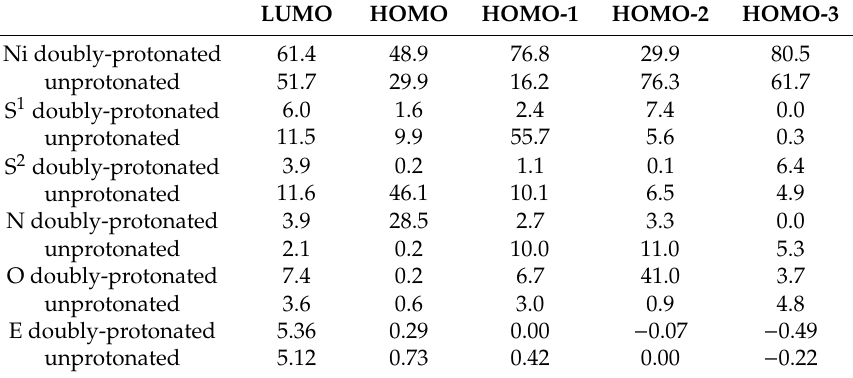
Figure 9. ( A ) Isosurface plots (0.03 a.u.) of the LUMO through HOMO-3 of the doubly-protonated (left) and unprotonated (right) computational models of the pH 7.4 form of the nickel-site of {Ni 2 (SOD mds )}. The energies were normalized to the non-bonding Ni(3d z2 ) orbital, highlighted in red. ( B ) Isosurface plots (0.03 a.u.) of the LUMO+1 through HOMO-5 of the disulfide bridged dinuclear {Ni 2 (SOD mds )} computational model. Table 1. Ni(3d), S(3p), N(2p), and water O(2p) Löwdin MO population analysis (%AO to MO) and energies (eV) relative to the Ni(3d z2 ) orbital for the LUMO through HOMO-3 of the computational models for doubly-protonated and unprotonated monomeric {Ni 2 (SOD mds )} computational models. Orbital compositions for the doubly-protonated model are given above the unprotonated model for each AO. HOMO